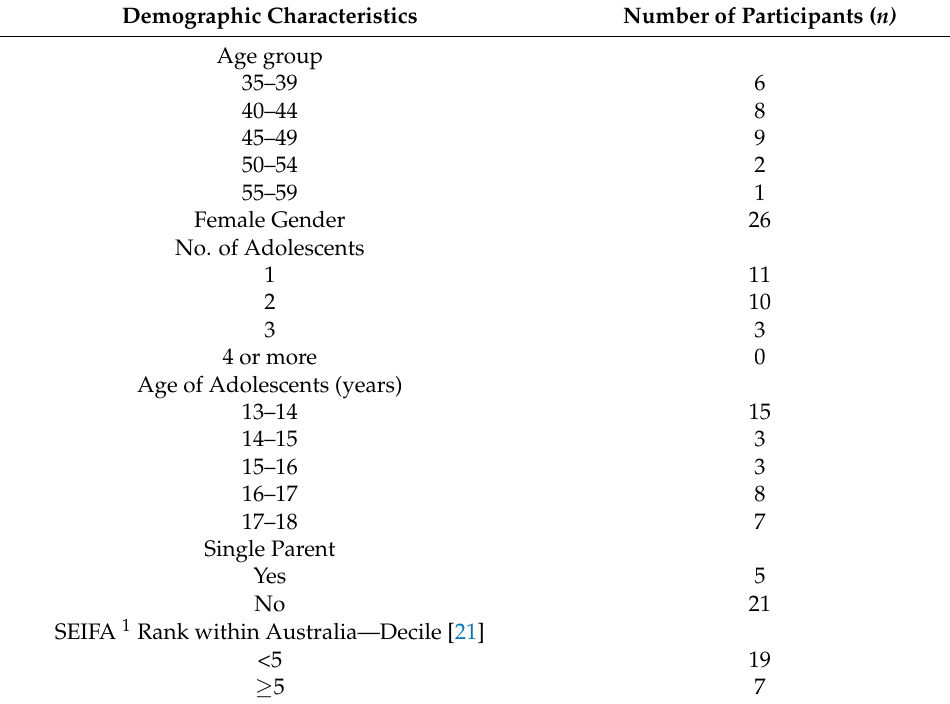
Table 2. Demographic information of interview participants (n = 26) *.